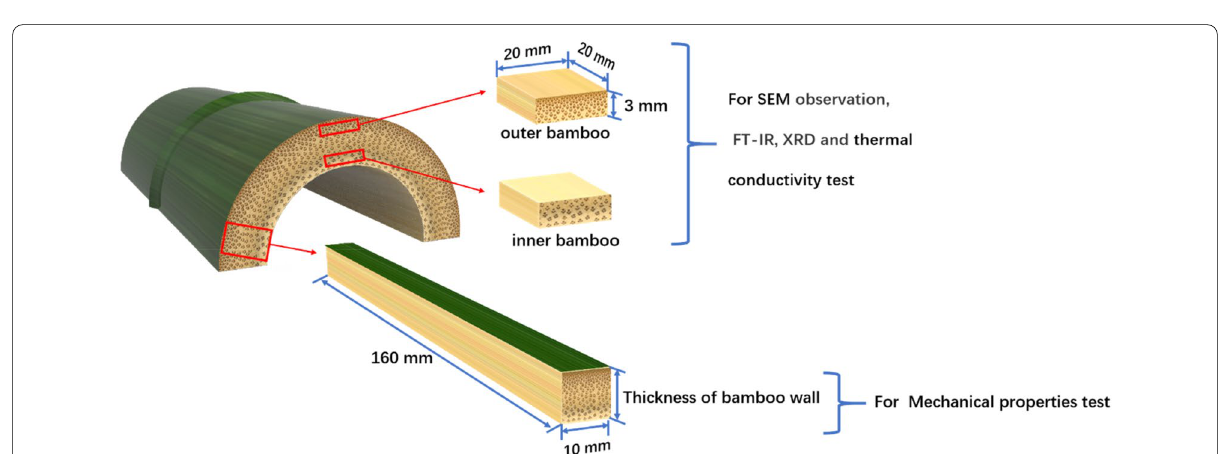
Fig. 1 Sample preparation from different parts of bamboo